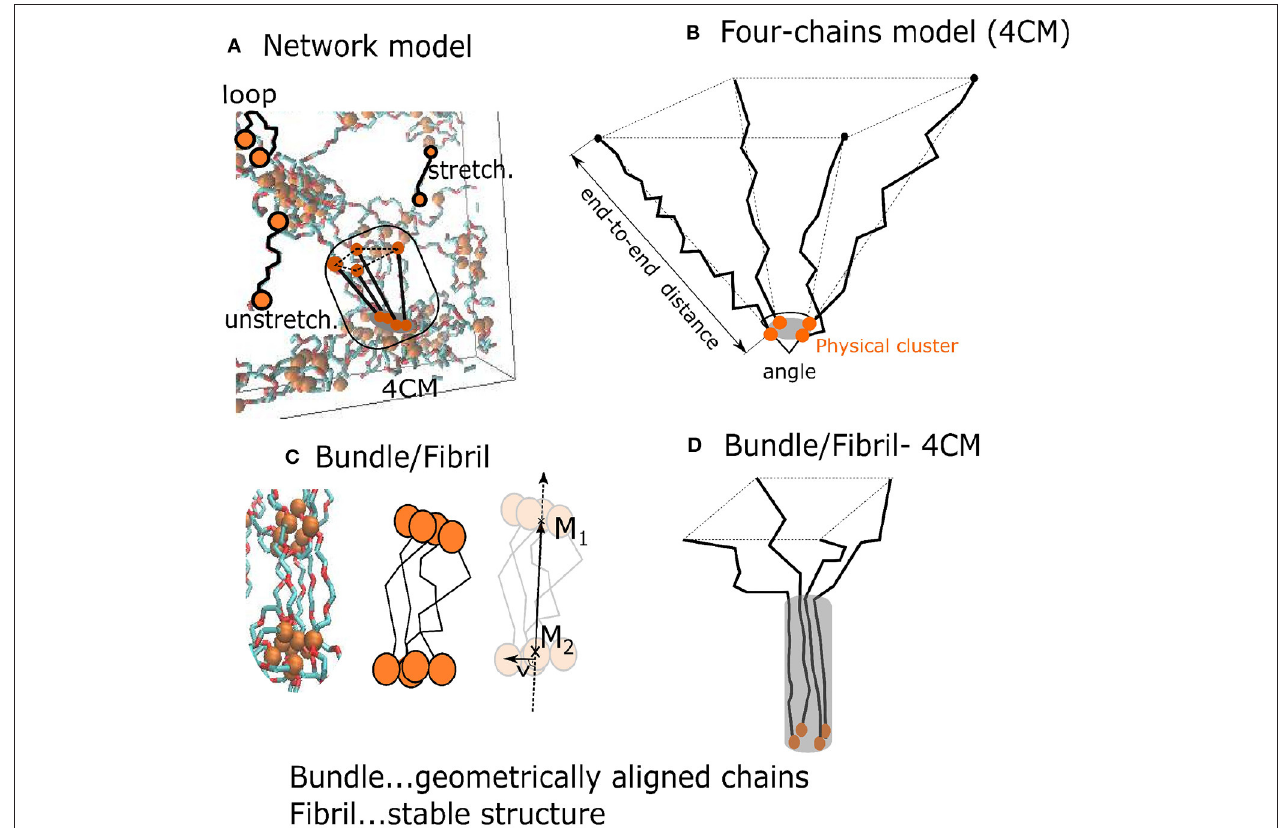
FIGURE 3 | Two models of the hydrogel: (A) A network model with a subset of four 4 PEG chains around a physical crosslink; (B) “4-chains model”—four randomly generated freely rotating chains with known length and mutual angle. The orange disks are interacting AA -groups; (C) a fibril with a fiber vector E M 1 M 2 ; (D) black lines denote chain segments aligned over some distance from the one end.